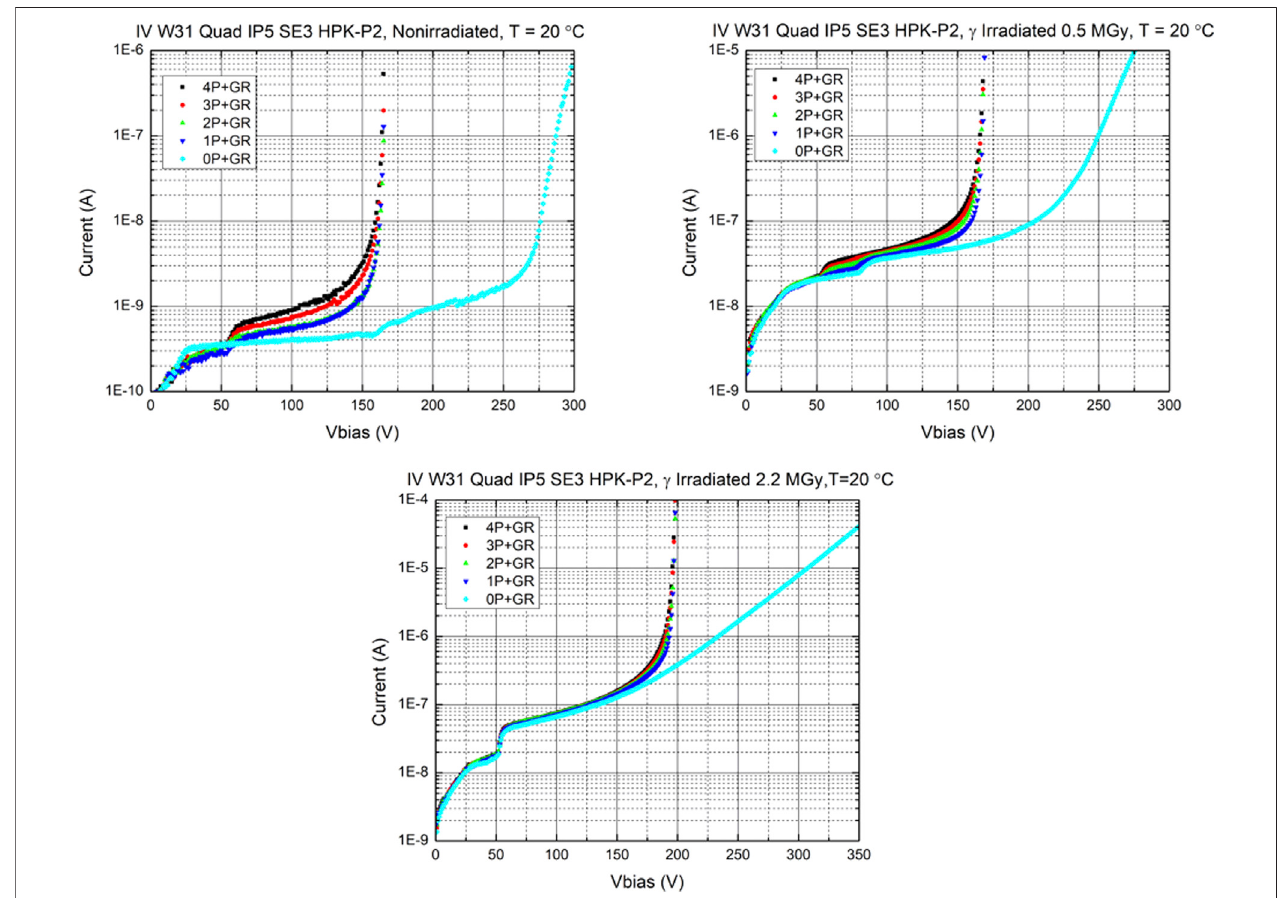
FIGURE 7 | Leakage current versus bias voltage for quad sensors taken from Wafer 31, measured (upper left) prior to irradiation, (upper right) after exposure to 0.5 MGy,and(lower)afterexposureto2.2 MGy.Inallcases,thetemperatureduringthemeasurementwas20 ° C.Ineachgraph,measurementsre fl ectthe fi vemodesin which the probes contact the guard ring plus n pads, where n ∈ {0,1,2,3,4}.